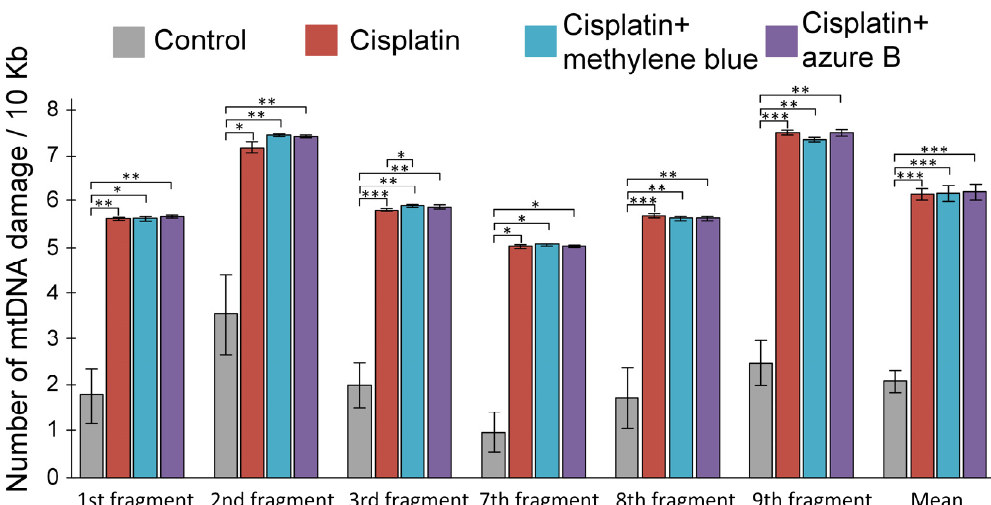
Figure 3. Impact of cisplatin, methylene blue, and azure B addition to intact renal mitochondria on the number of mtDNA damage. Differences are statistically significant: * p < 0.05, ** p < 0.01, *** p < 0.001 (Mann–Whitney test). The results are expressed as means ± SEM. All measurements were provided in at least four repetitions.